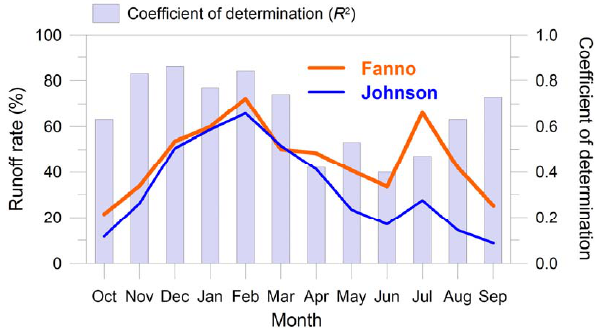
Fig. 2. Monthly runoff rate (%) that indicates the ratio of monthly runoff to monthly precipitation for 2000-2006 and monthly coefficient of determination between the Fanno daily streamflow (USGS 14206950) and the Johnson daily streamflow (USGS 14211500)